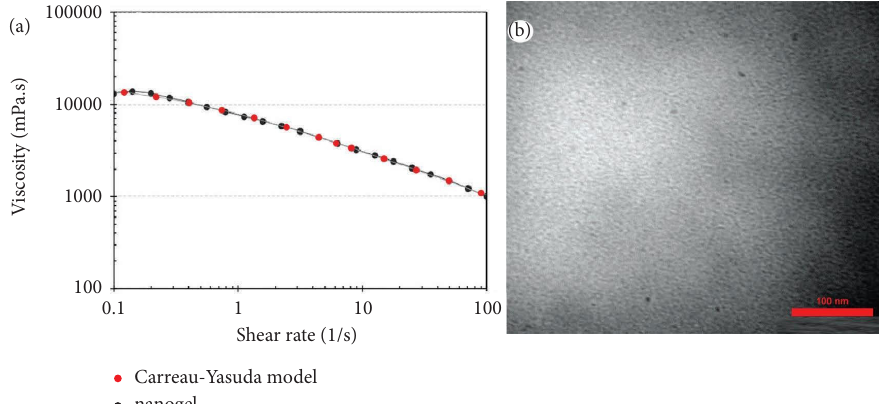
Figure 2: (a) Viscosity of the nanogel at diferent shear rates proved Carreau-Yasuda regression model and (b) TEM image of the nanogel (scale bar �